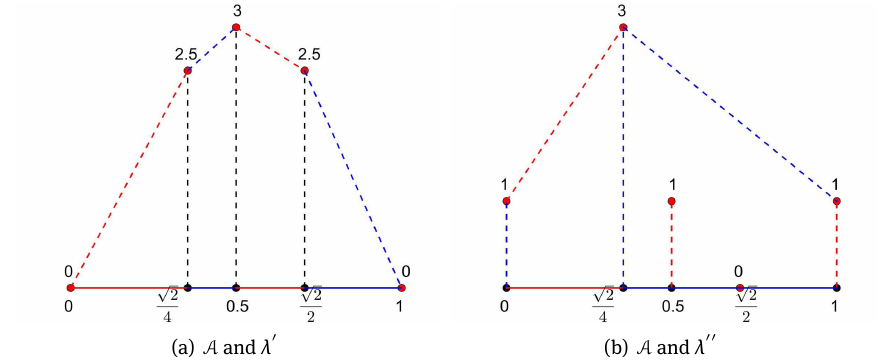
Figure 12: Regular decompositions of A